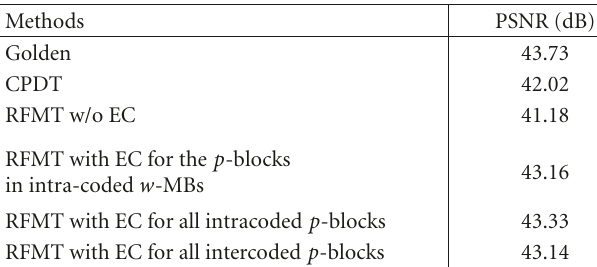
Table 7: E ff ectiveness of error correction for di ff erent kinds of p - blocks.